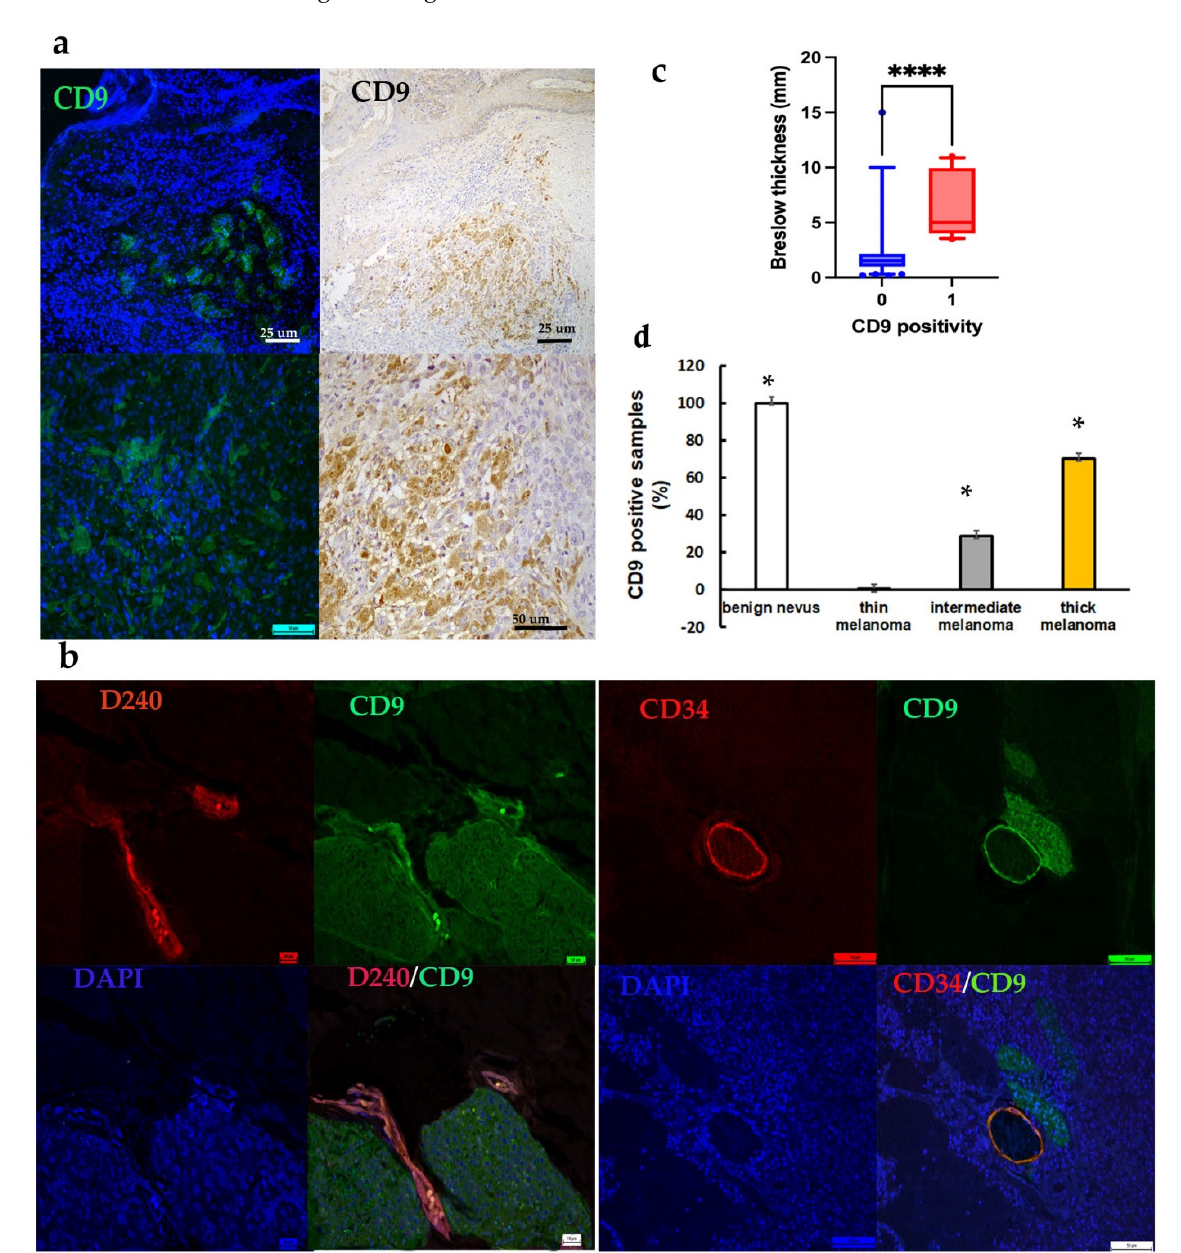
Figure 3. ( a ) Similar staining pattern of CD9 in positive tumor clusters using immunofluorescence and immunohistochemistry. ( b ) Endothelial vessels (CD34+) and lymphatic vessels (D240+) resulted CD9 positive using double immunofluorescence (orange staining). ( c ) CD9 expression related to Breslow thickness in cutaneous melanoma (0: negativity; 1: positivity; Student t test, **** p < 0.0001). ( d ) Statistical representation of CD9 positivity in benign nevi and cutaneous melanomas grouped according to Breslow thickness (ANOVA and Bonferroni test, * p < 0.05). Immunohistochemical double staining with antibodies against CD9 and CD34 or D240 revealed an interesting finding: CD9 positive clusters, in which CD9 appeared to be re-expressed, were predominately located at sites of invasion near (Figure 4a–c, g–i) or inside the blood (CD34+, Figure 4d–f) or lymphatic vessels (D240+, Figure 4l–n). In sum- mary, CD9 was found to be downregulated or absent in the main tumor mass, but it was still expressed immediately adjacent or within vessels.